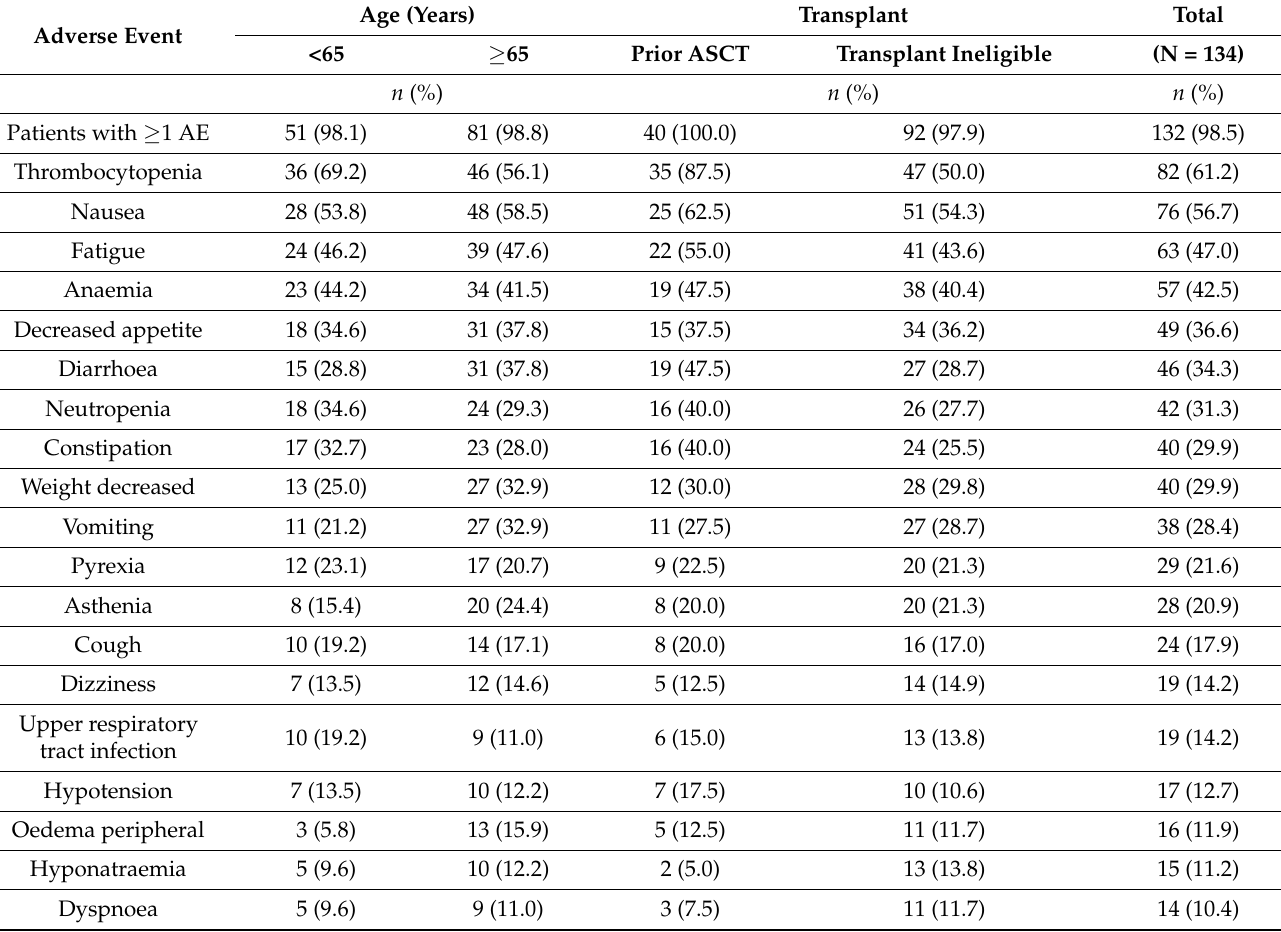
Abbreviations: AE = adverse event, ASCT = autologous stem cell